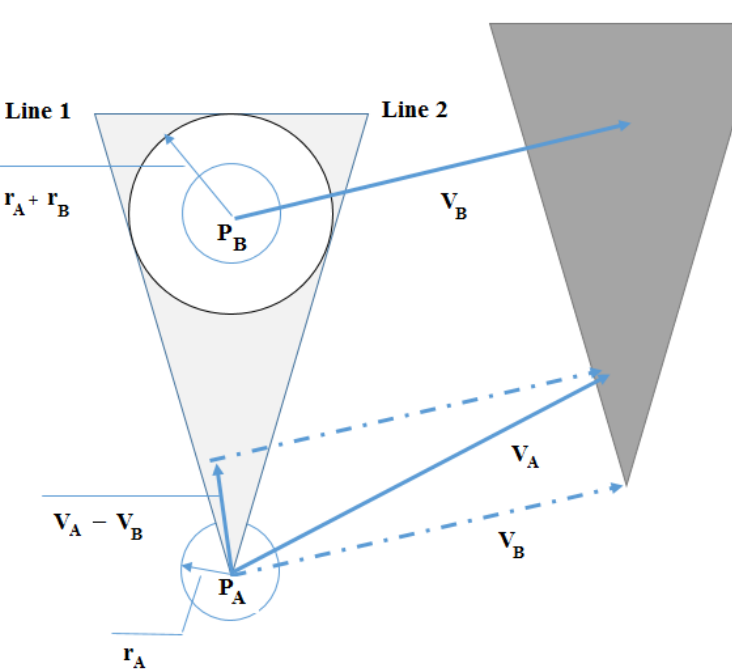
Figure 6. Velocity obstacles. There are two vehicles A and B with the respective radii r A and r B at the respective positions p A and p B . v A and v B are the velocity vectors of vehicles A and B respectively. The light cone represents the velocity obstacle on vehicle A if vehicle B was stationary. The dark ( v ) represents the same velocity obstacle when taking into account vehicle B ’s cone denoted as VO A B B velocity v B